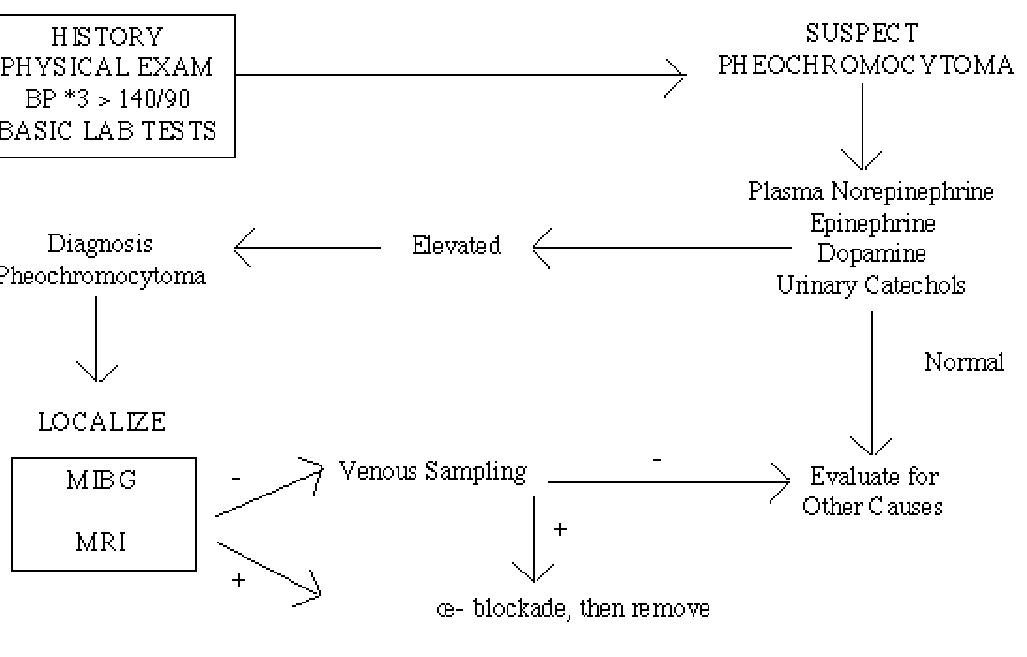
FIGURE 6. Evaluation for